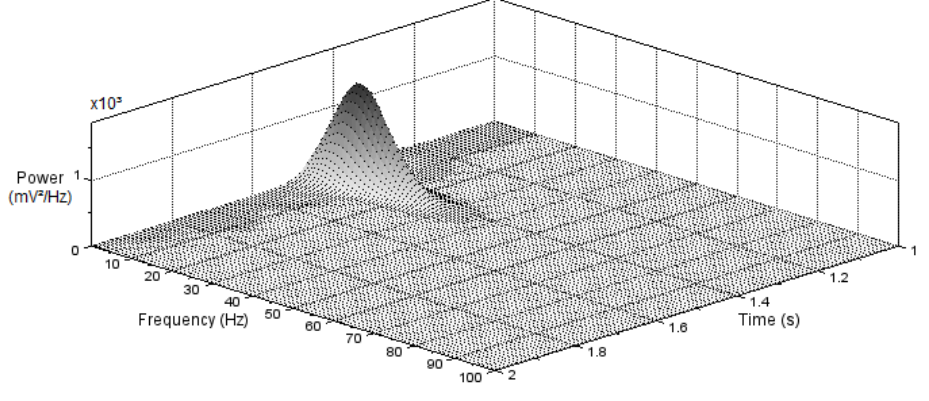
Figure 9. Time–frequency spectrogram after noise